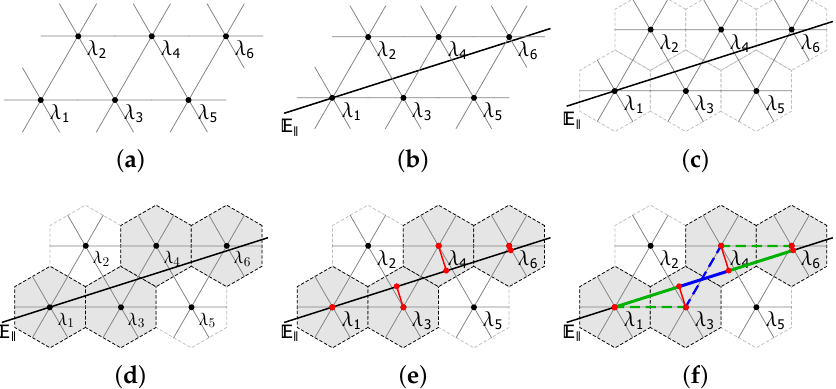
Figure 1. Step-by-step illustration of the cut-and-project process for the triangular lattice Λ = A 2 ( a ) projecting onto a 1-dimensional tiling space E (cid:107) ( b ). The Voronoi cells for the lattice are all regular hexagons ( c ) and it is only those vertices with Voronoi cells that intersect E (cid:107) which are selected ( d ). These vertices are then projected onto E (cid:107) and define the vertices of the tiling of E (cid:107) ( e ). The lattice edges (dashed lines) connecting the selected lattice points are projected to E (cid:107) to form the (1-dimensional) tiles which fill E (cid:107) ( f